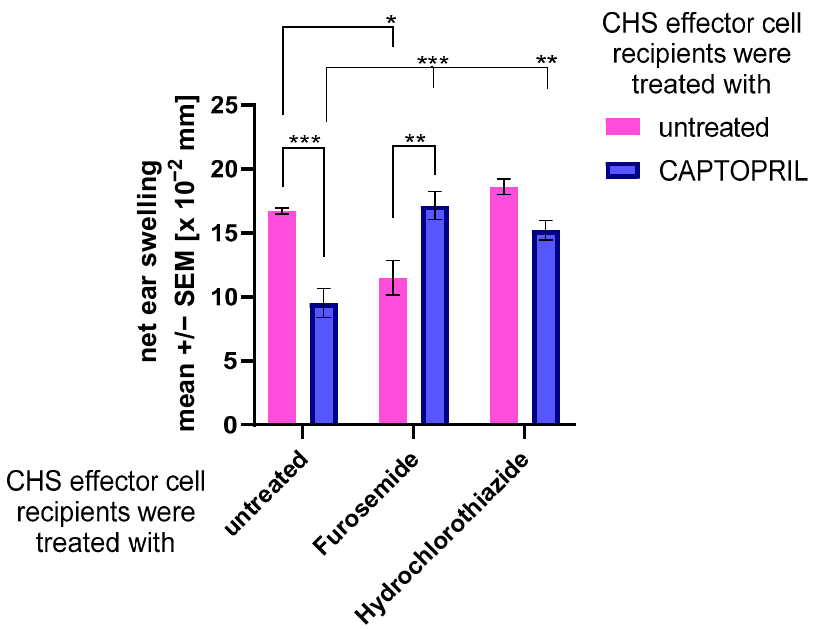
Figure 3. CHS reaction in mouse recipient of PCL-induced CHS effector cells adoptively transferred to drug-treated mice. Recipients of PCL effector cells were treated intraperitoneally with captopril with or without furosemide or hydrochlorothiazide for eight consecutive days, while donors, on the third day, were sensitized with PCL on the shaved abdominal skin. Five days later, lymph node and spleen CHS effector cells were adoptively transferred by intravenous injection into drug-treated recipients. Just after transfer, recipients were challenged with a 0.4% PCL to elicit CHS ear swelling, measured with an engineer’s micrometer 24 h later. The averaged results of ear-thickness increase, after subtracting the ear-thickness increase in non-sensitized but challenged littermate mice, were expressed as delta +/ − standard error of the mean. Two-way ANOVA with Tukey’s post hoc test. * p < 0.05; ** p < 0.01; *** p < 0.005, n = 4 (in each drug-treated mice test group) + negative control n = 3, N = 2.